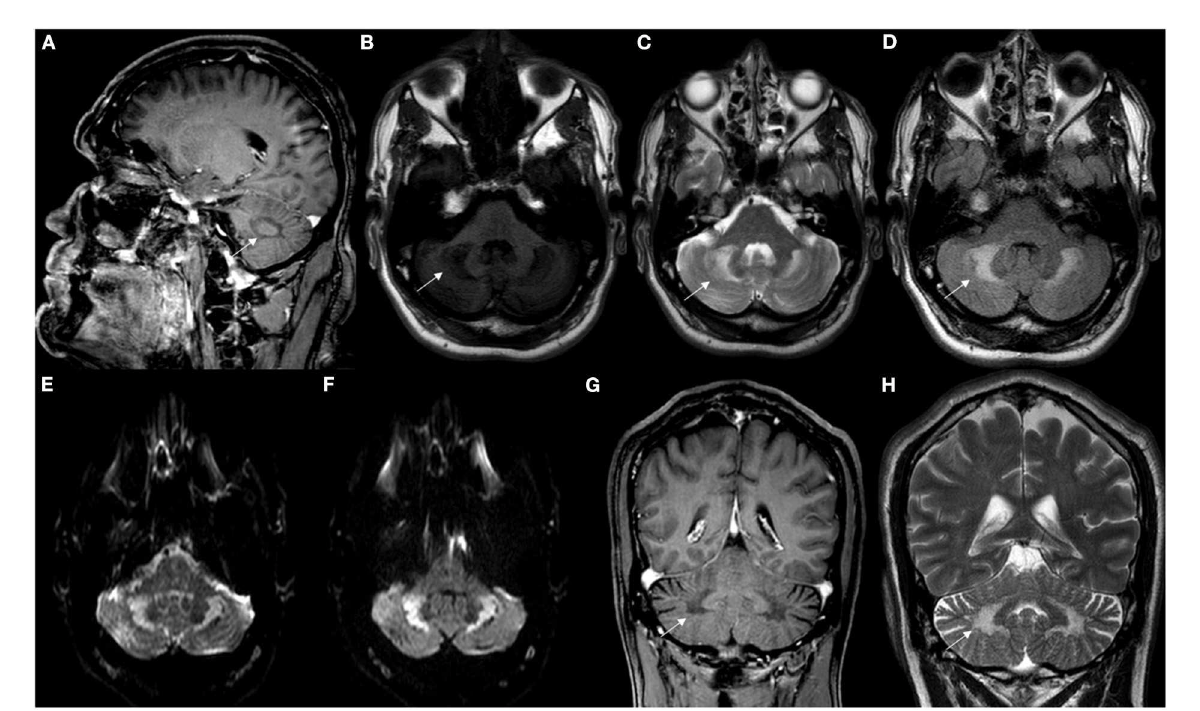
FIGURE5 Neuroimaging patterns observed in CTX. (A) Sagittal T1-weighted brain MRI showed hypointense signal in deep cerebellar white matter (white arrow). Axial brain MRI disclosed signal change in deep cerebellar white matter (white arrows) hypointense in T1W (B) and hyperintense in T2W (C) and FLAIR sequences (D) . Axial brain MRI disclosed hyperintensity in deep cerebellar white matter in DWI (E) and ADC sequences (F) . Coronal brain MRI showed hypointensity in the deep white matter in T1W imaging (G) , as well as corresponding hyperintensity (white arrows) in T2W imaging (H)